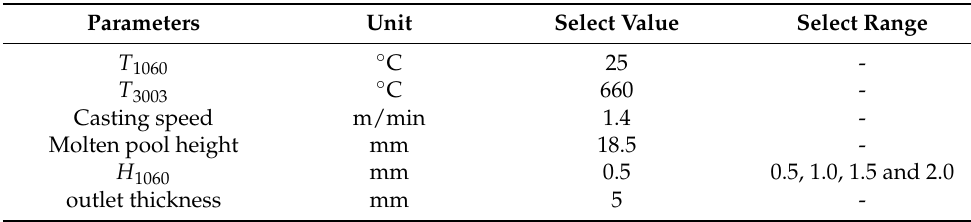
Table 4. Process Parameters of